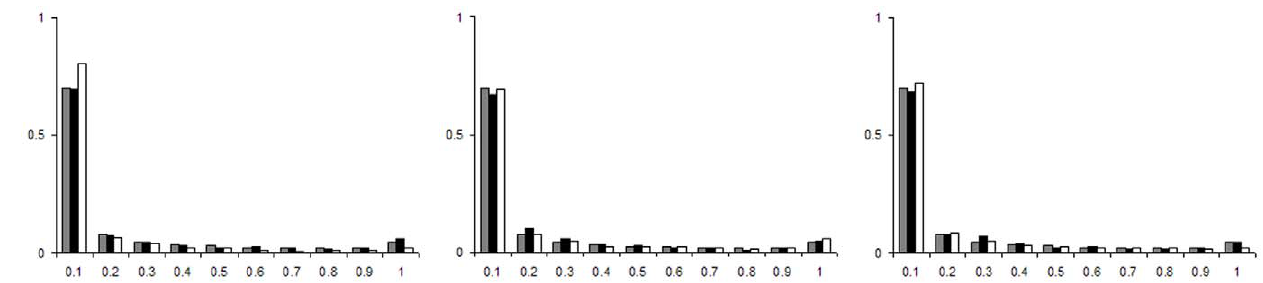
Figure 2. Frequency spectra of indels and SNPs. SNPs in noncoding regions always in grey. These are contrasted to synonymous SNPs (black) and nonsynonymous SNPs (white) in left histogram, to 1 bp insertions (black) and 1 bp deletions (black) in middle histogram and to longer than one bp insertions (black) and deletions (white) in right histogram.